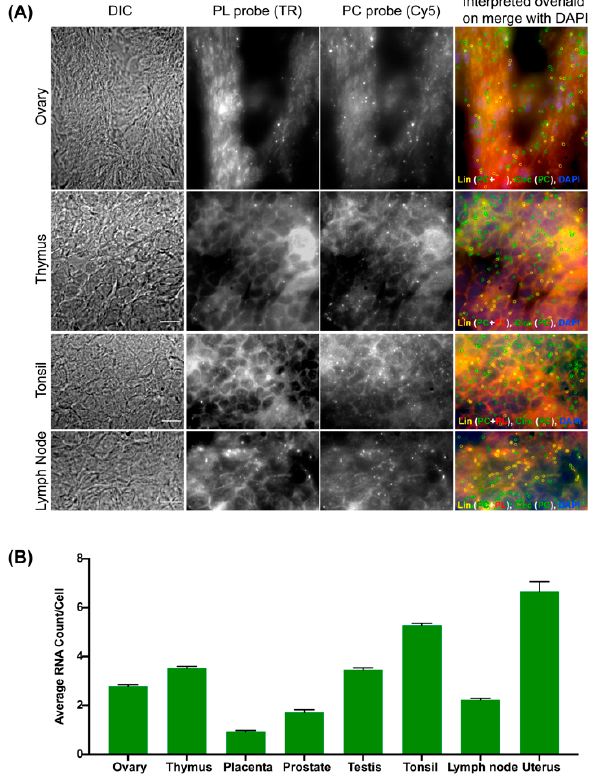
Figure 7. Expression profiling of circPOK in frozen human tissue samples using circFISH. ( A ) Rep- resentative image of the circFISH imaging of a panel of the frozen human tissue array (containing ovary, thymus, tonsil, and lymph node) with PL and PC probes. Columns from the left: DIC; raw merged z stacks of cells for PL probes labeled with TR; raw merged z stacks of cells for PC probes labeled with Cy5; and a merged image of the two channels with TR spots pseudo-colored red and Cy5 pseudo-colored green, overlaid on DAPI with MATLAB-interpreted spots showing the linear and circular RNAs as yellow and green, respectively. ( B ) Quantification of the circPOK signals to identify the average circPOK RNA count per cell across multiple tissue types. The error bars indicate the 95% confidence interval. At least 100 cells were counted for each condition. The scale bar is 5 μ m.